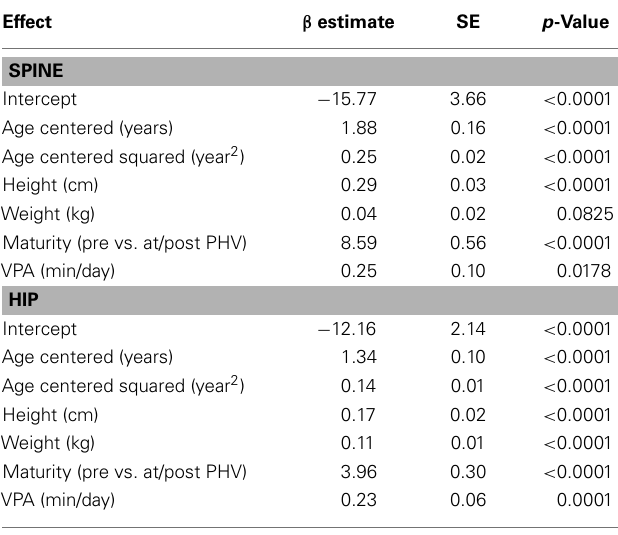
Table 4 | Fixed-effects of the multi-level models examining the association ofVPA with spine and hip BMC in males .